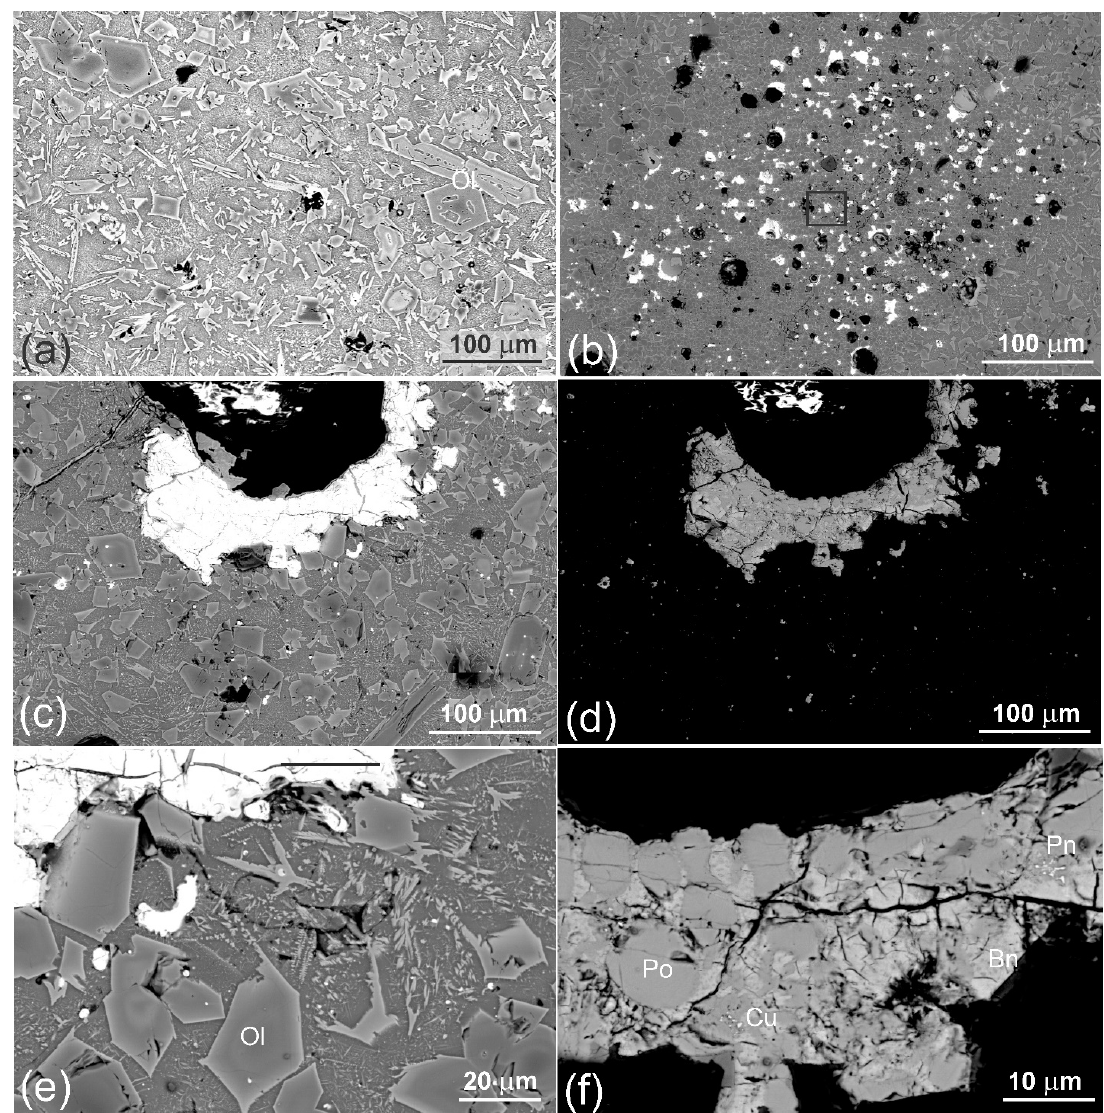
Figure 4. SEM-backscatter electron (SEM-BSE) images of a sample of non-magnetic slag (Figure 2d). ( a ) Zoned prismatic olivine (Ol) crystals, Fe-rich at the rim, in a matrix with skeletal olivine and olivine dendrites. ( b ) Region with a concentration of Cu-Fe rich sulfide nodules. The rectangle in the center is the area on which a SEM-energy dispersive spectroscope (SEM-EDS) scan was performed (Figure 5). ( c,d ) Region rich in Cu-Fe sulfides (top) in a matrix of olivine (bottom). ( c ) High brightness to emphasize the olivine matrix, ( d ) Low brightness to emphasize sulfides. ( e ) Enlarged area of ( c ) illustrating euhedral zoned olivine and skeletal olivine in the matrix. ( f ) Enlarged area of ( d ) with pyrrhotite (Po), bornite (Bn), copper (Cu, white dots) and pentlandite (Pn, white dots). Abbreviations for minerals here and in other figures refer to IUGS convention [35].